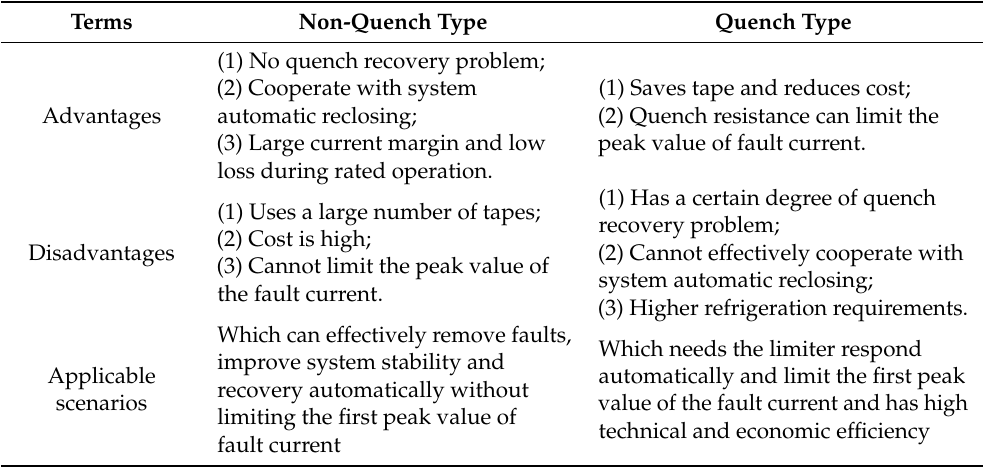
Table 3. Comparison of advantages and disadvantages of non-quench type and quench type